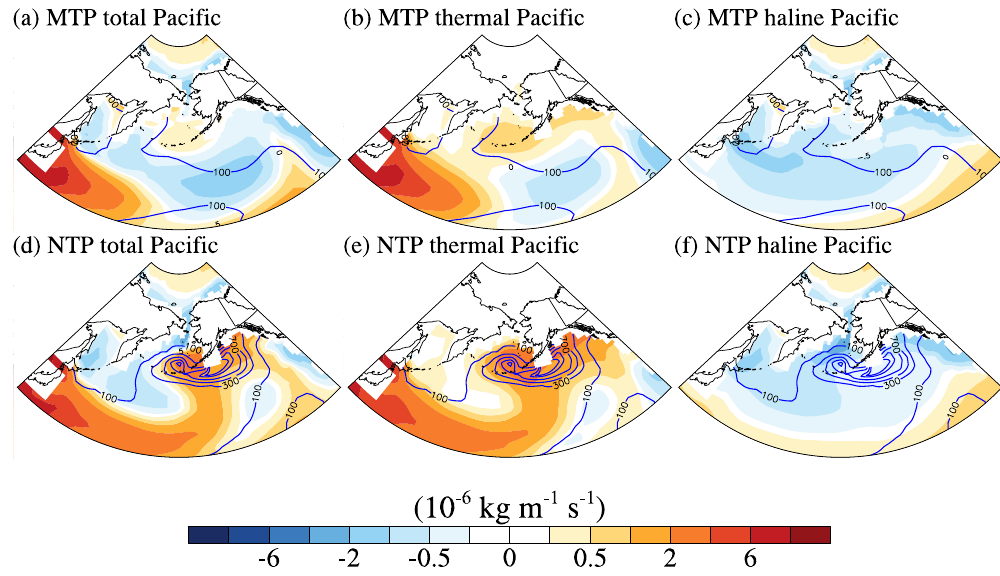
Figure 7. The same as Fig. 5, but for the North Pacific (30–80 ◦